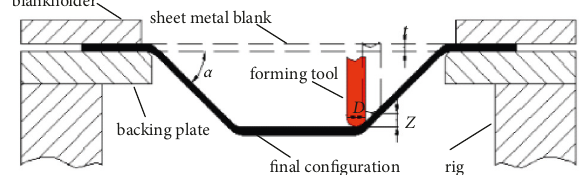
Figure 1: Diagram of single point incremental forming principle.